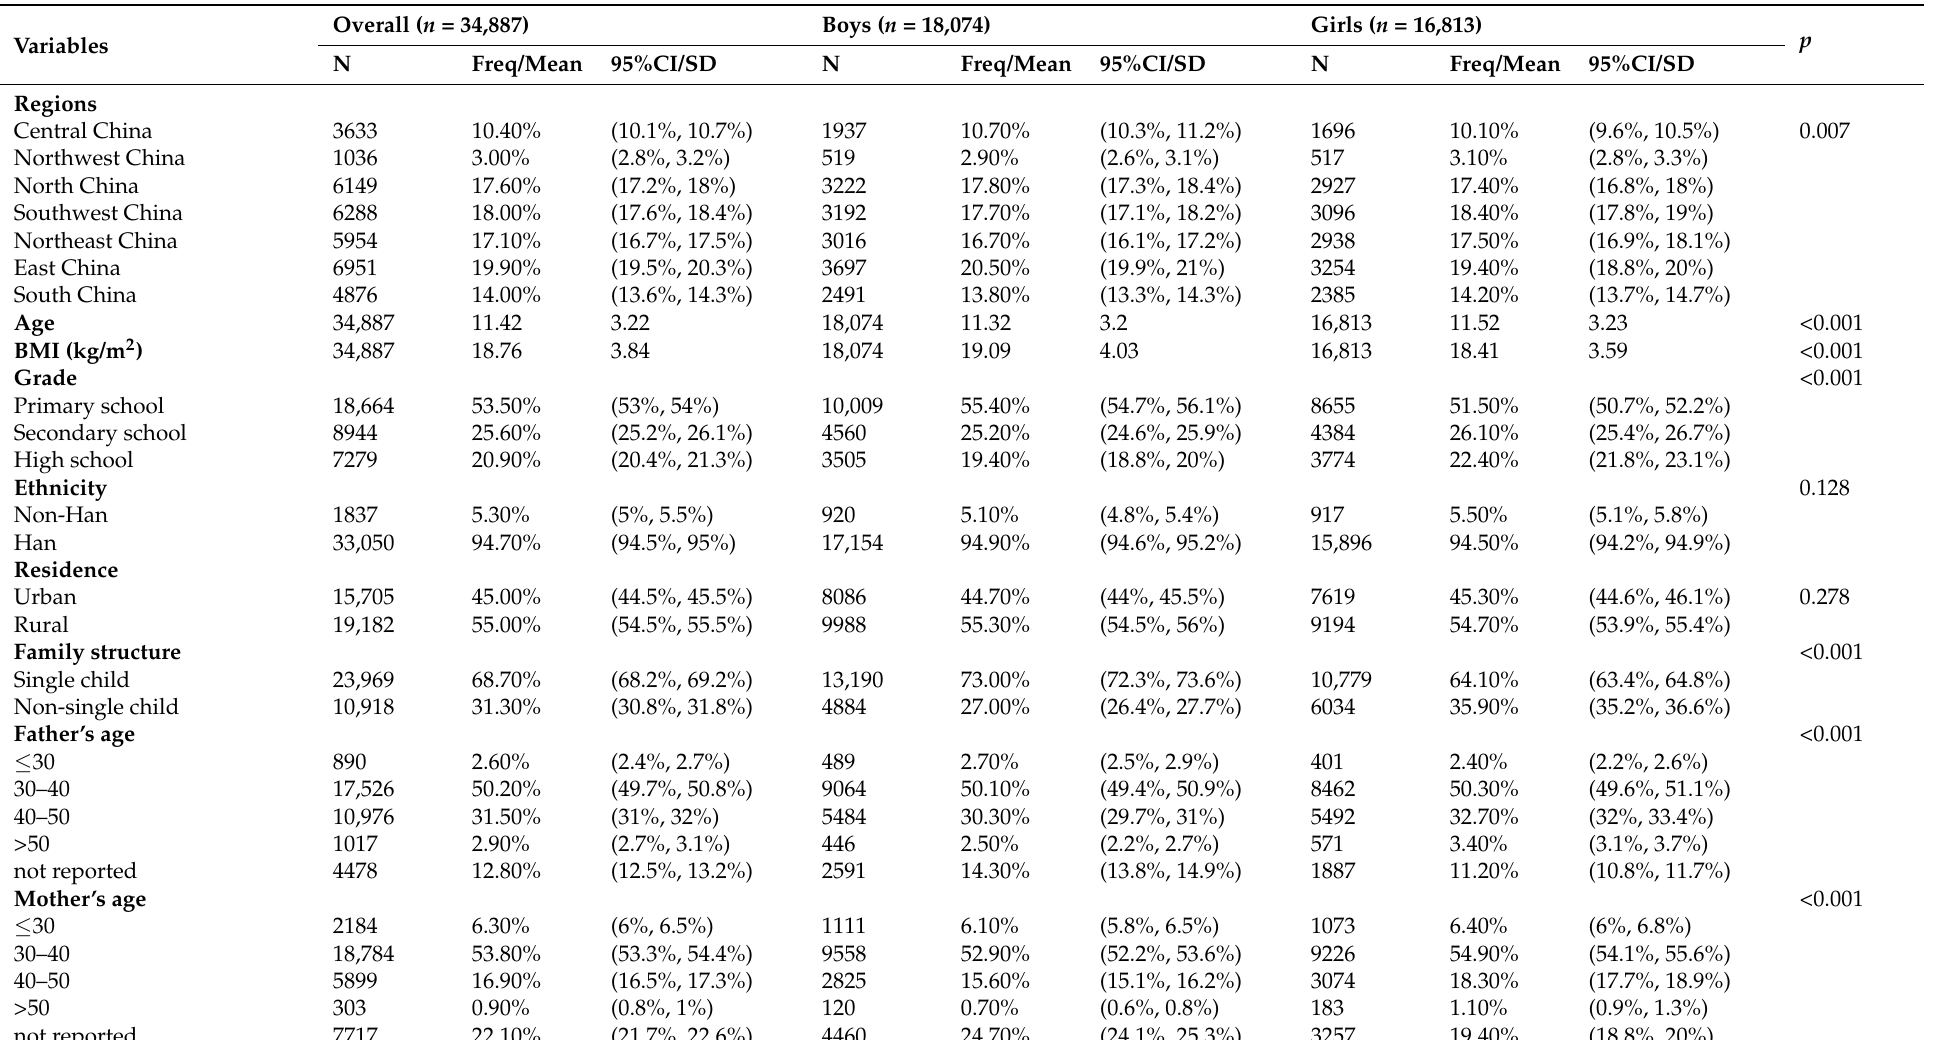
Table 1. General characteristics of the study